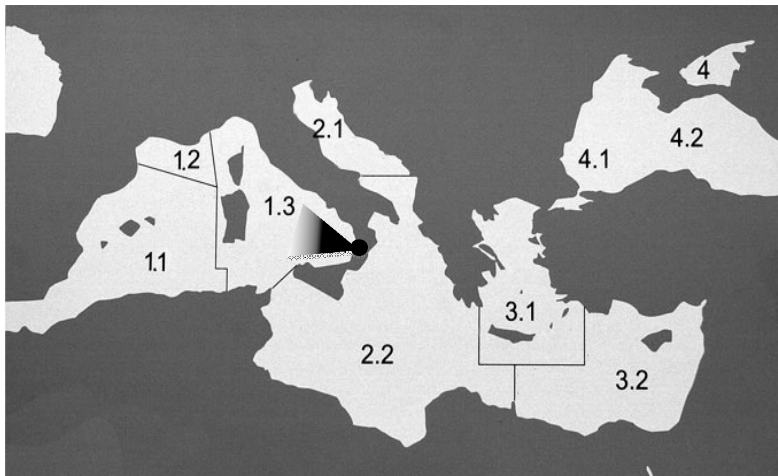
Figure 1. The sampling area: Food and Agriculture Organization (FAO) fishing area 37; division 37.1.3.